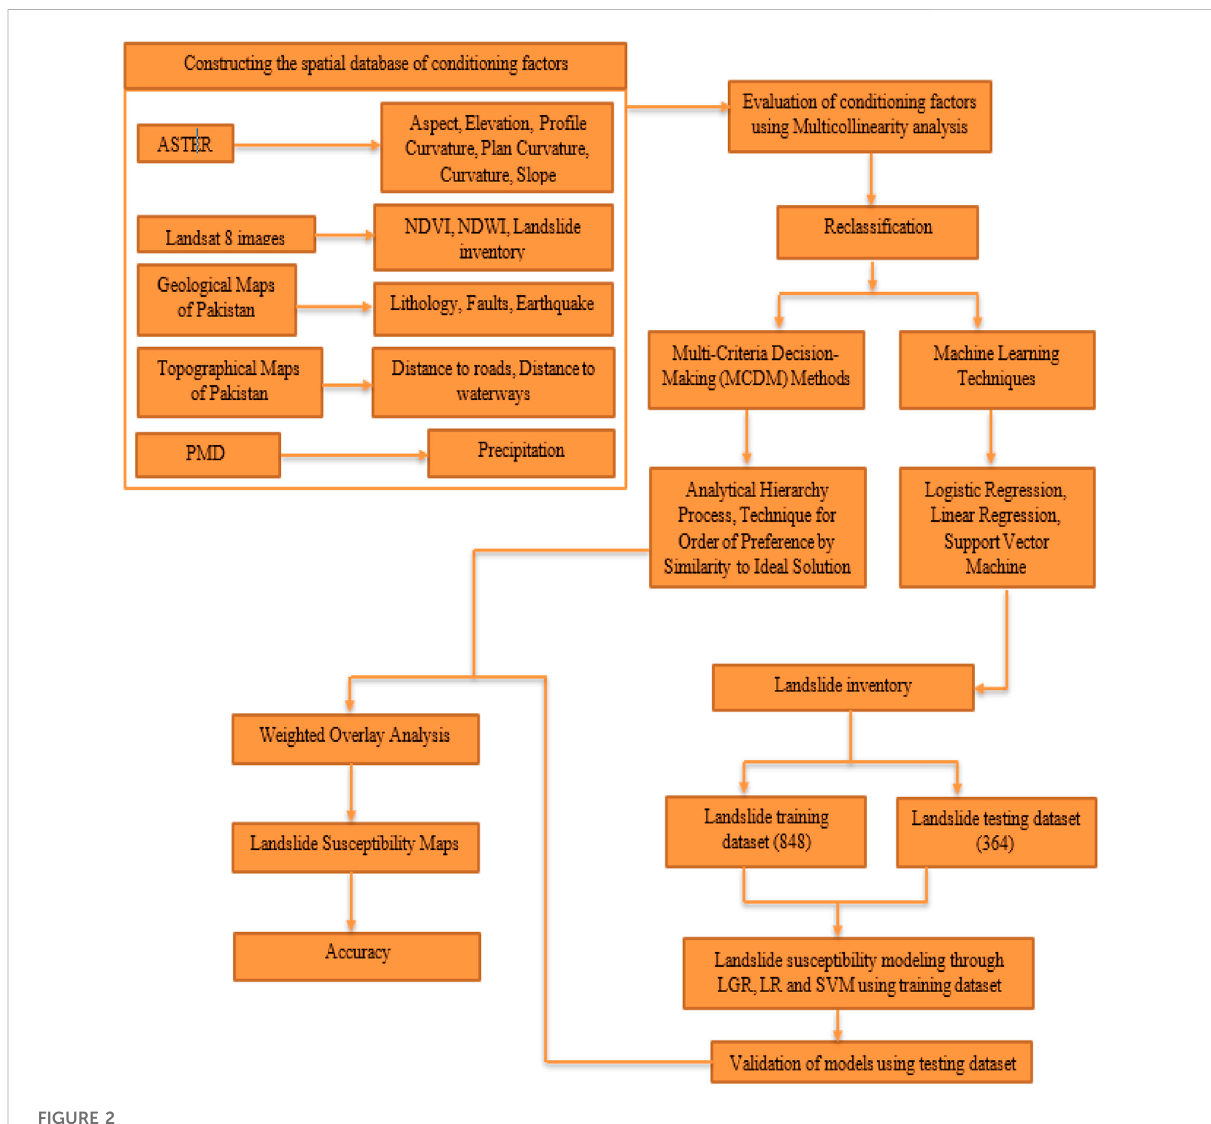
FIGURE 2 Methodology fl ow